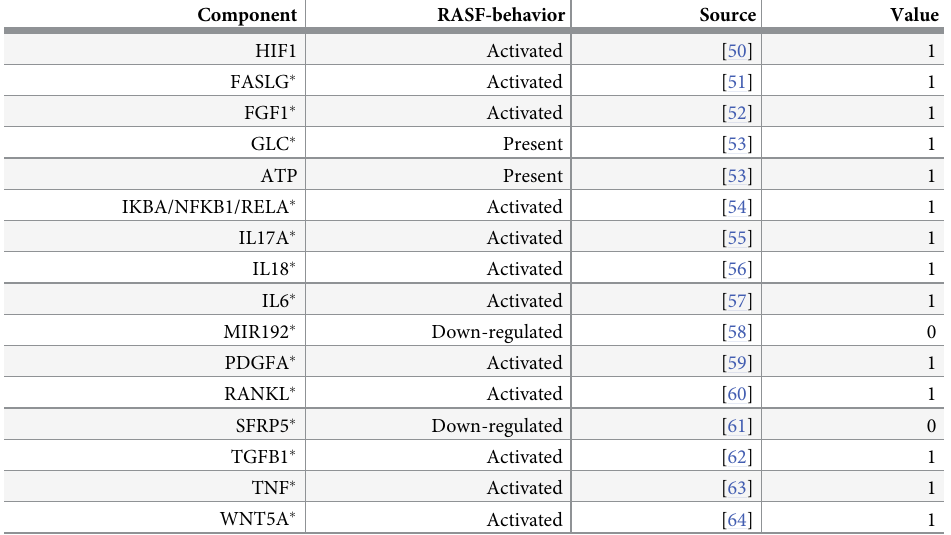
Table 2. RASF-specific initial conditions extracted from literature. Regulatory model’s inputs are marked with an asterisk.